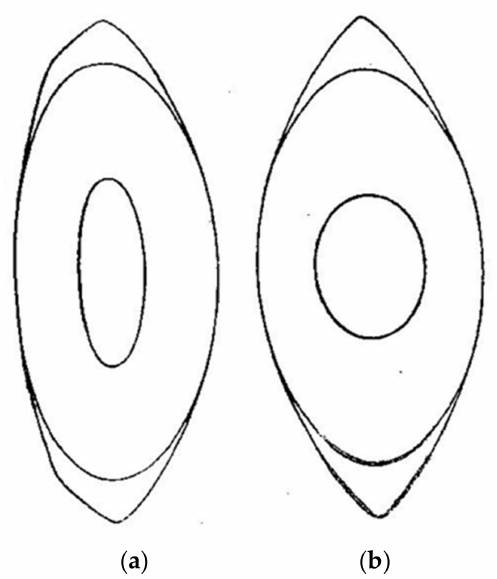
Figure 1. Original drawing of the shape of the ( a ) relaxed and ( b ) accommodated lens proposed by Gullstrand [4]. Lines represent the isoindicial surfaces delimiting the cortex and the nucleus of the lens. Presented with the permission of Dover